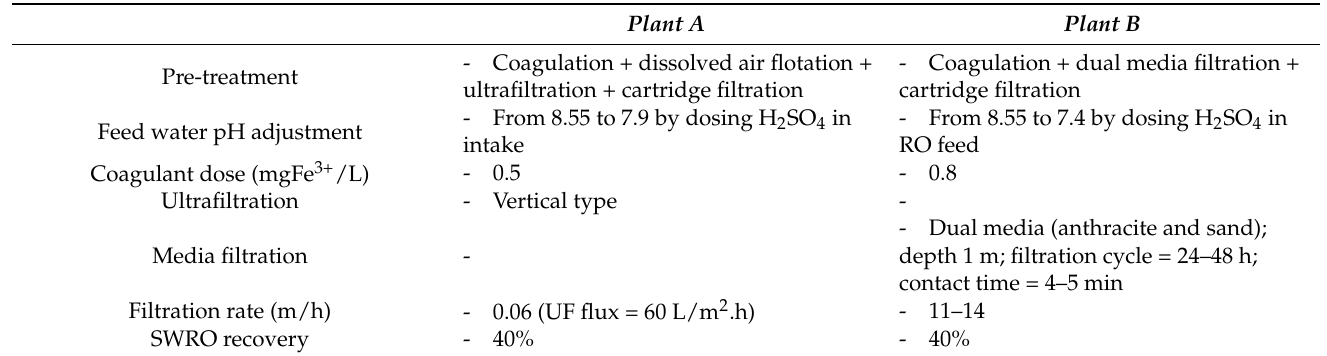
Table 3. Operating conditions of the three in seawater reverse osmosis (SWRO) desalination plants. Plant